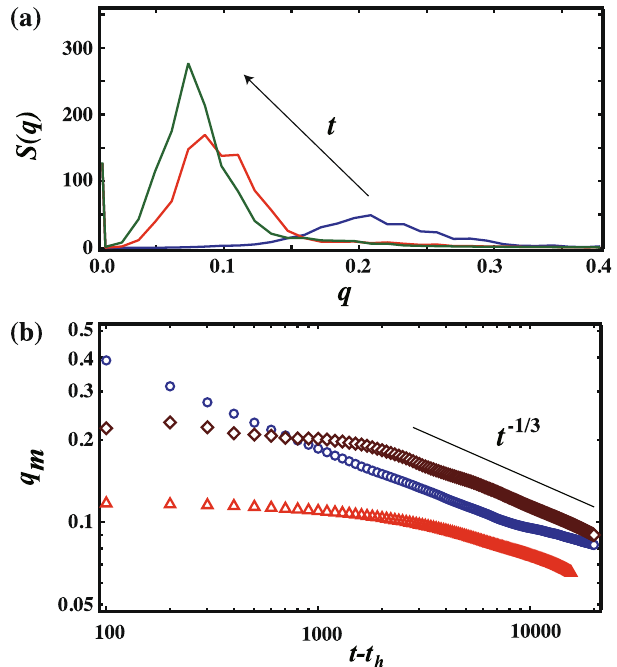
Figure 3. ( a ) Structure factor S ( q ) for the random droplet pattern when v tri = 10, observed over time. We show S ( q ) at t = 800, 5000 and 20000. ( b ) Time evolution of the peak position q m as a function of t − t h . t h is the time after the trigger has covered the whole box, and the system is homogeneously quenched. The circle symbol corresponds to q m for the random droplet pattern. Diamond and triangle symbols correspond to q m for concentric circles and the dendritic pattern, respectively. The solid line in ( b ) shows ( t − t h ) − 1/3 .